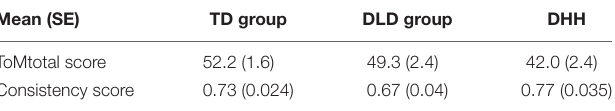
TABLE 2 | Mean ToM total scores (standard errors within brackets), mean consistency scores, and standard errors within brackets for children in the TD-group, children in the DLD group, and children in the DHH